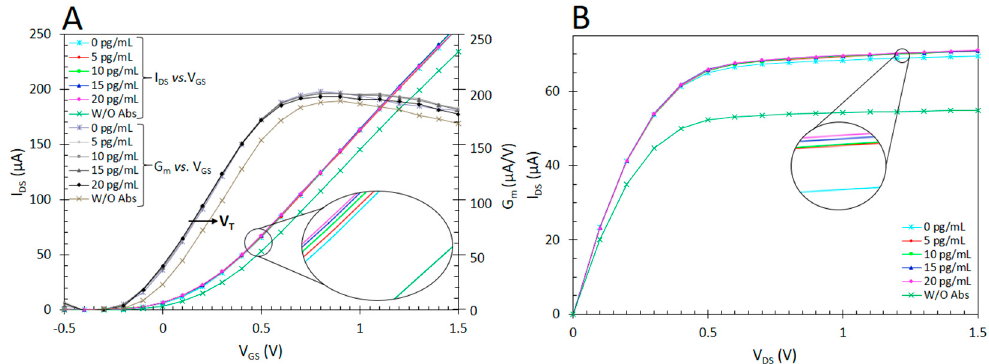
Figure 7. ImmunoFET characteristics for TNF ‐α detection in artificial saliva under various TNF ‐α concentration: ( A ) electrical characteristics (I DS vs. V GS ) of the ImmunoFET at constant V DS Value (0.5 V); ( B ) output characteristics (I DS vs. V DS ) of the ImmunoFET under constant V GS value (0.5 V).